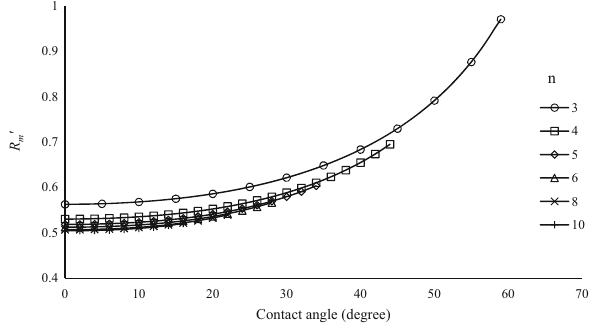
Fig. 5 Normalized threshold radius, R m polygons